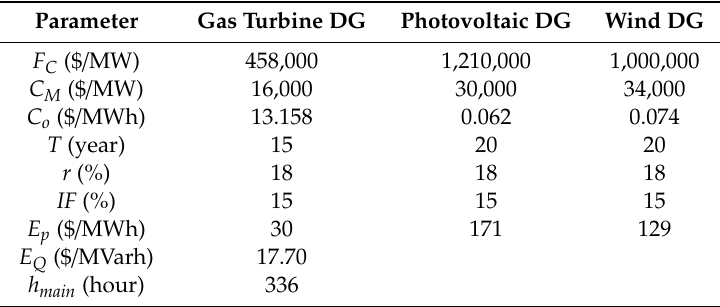
Table 1. Technical and economic information about the BREC network.